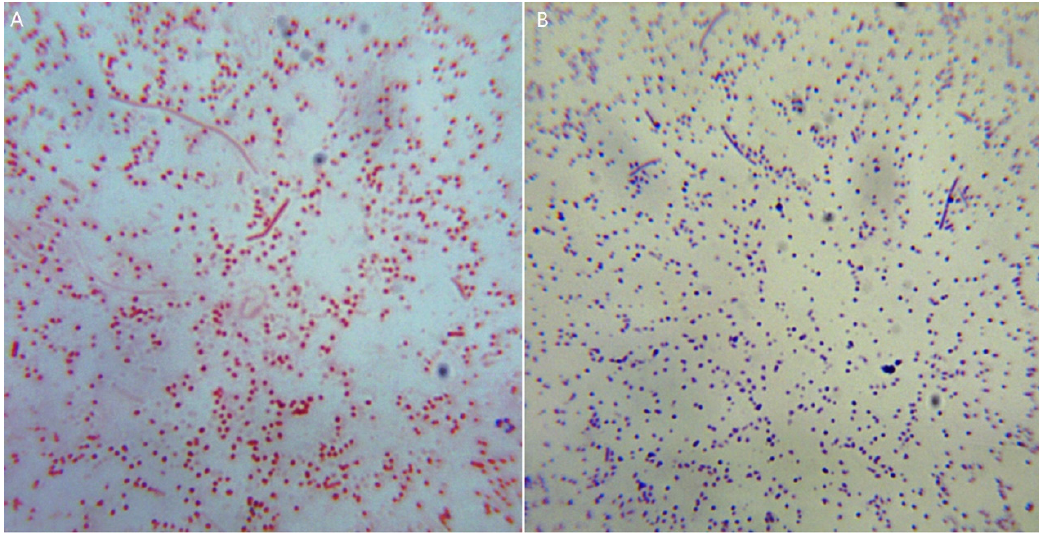
Figure 4. Morphological characteristics of isolated bacteria under microscope (×1000). ( A ) Gram stain; ( B ) Wright stain.